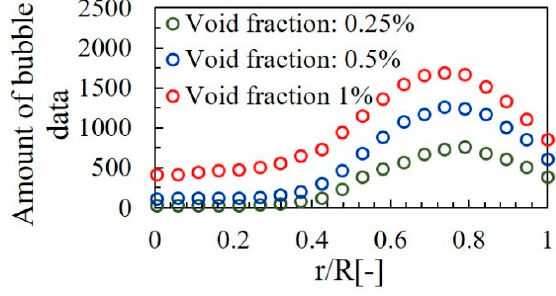
Figure 21. Amount of bubble data in each void fraction.